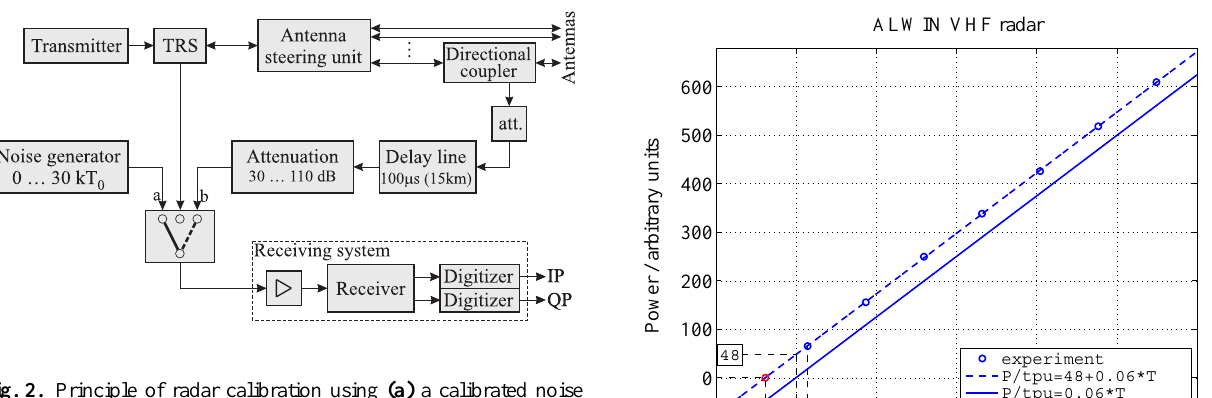
Fig. 2. Principle of radar calibration using (a) a calibrated noise source, and (b) the delayed and attenuated transmitted signal.